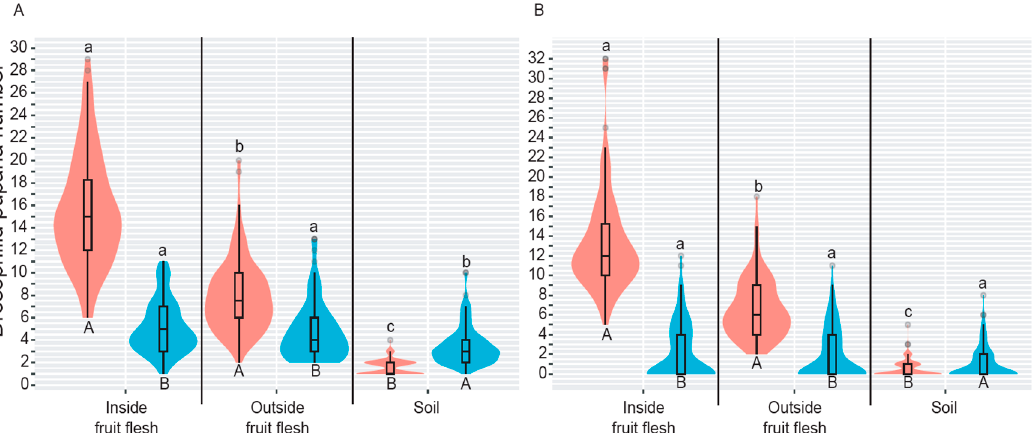
Figure 4. Violin-box plots showing the kernel probability density of a drosophilid (saprophytic Drosophila spp. from D. melanogaster group = red, and Drosophila suzukii = blue) choosing a specific microhabitat in peach and in guava. Violin-box plots showing the kernel probability density. Different letters show significant differences at p = 0.05 (LSD test with the Bonferroni–Holm adjustment method). To compare all microhabitats, lowercase, and uppercase letters are used, respectively, for Drosophila spp. and Drosophila suzukii . The rectangular white bar in the center of the violin box and the black horizontal line inside the bar show the interquartile range and the median, respectively; the black vertical lines stretched from the bar show the lower/upper adjacent values, while black dots display the outlier data. Table 1. Summary of the Kruskal–Wallis test on puparia abundance comparison between saprophytic Drosophila spp. and D. suzukii recorded by microhabitat and host fruit species.